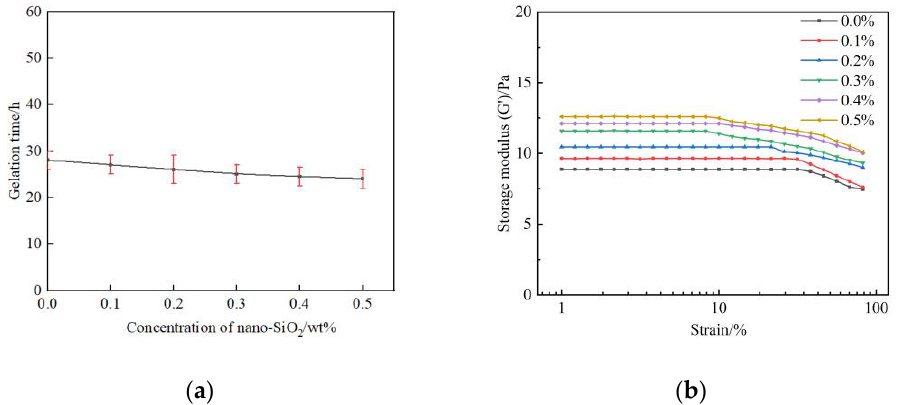
Figure 5. Effect of nano-SiO 2 on gelation performance of polymer gel: ( a ) Gelation time; ( b ) Gel strength.